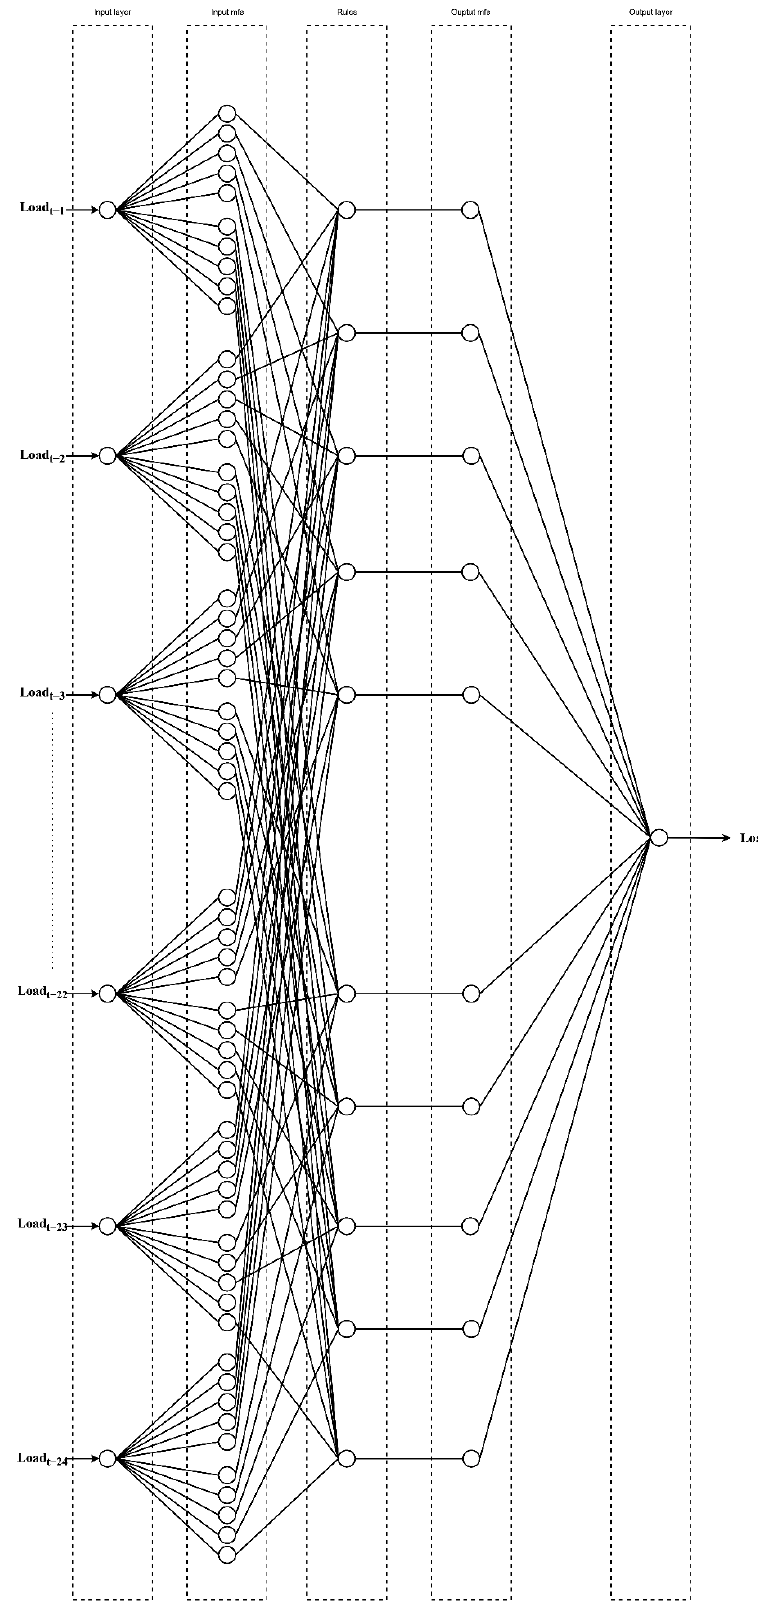
Figure 3. Structure of the TSK ANFIS used in the study.